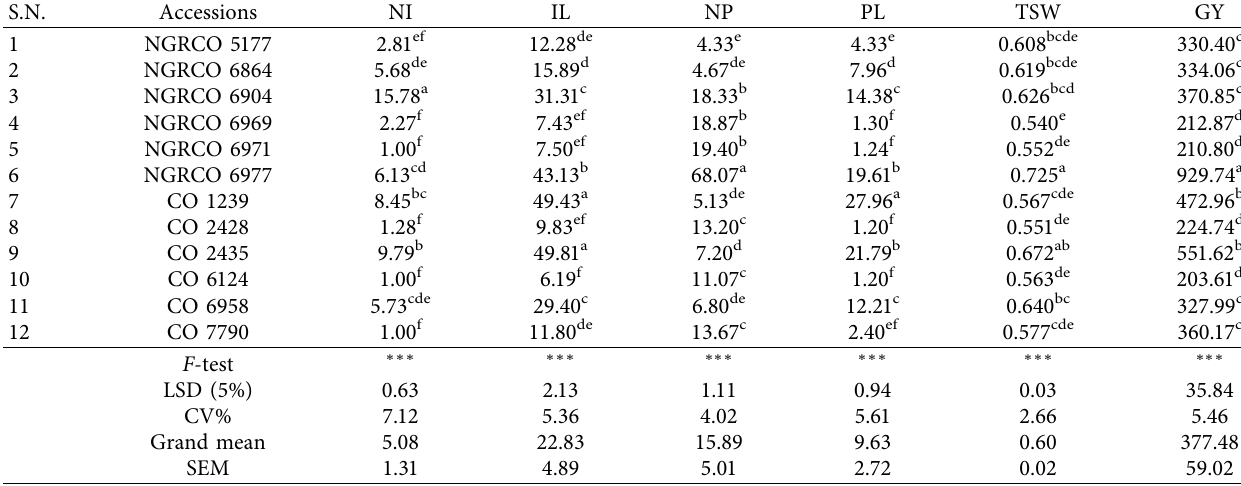
Table 2: Mean performance of twelve amaranth accessions for reproductive traits in Lamjung, in 2021. S.N.